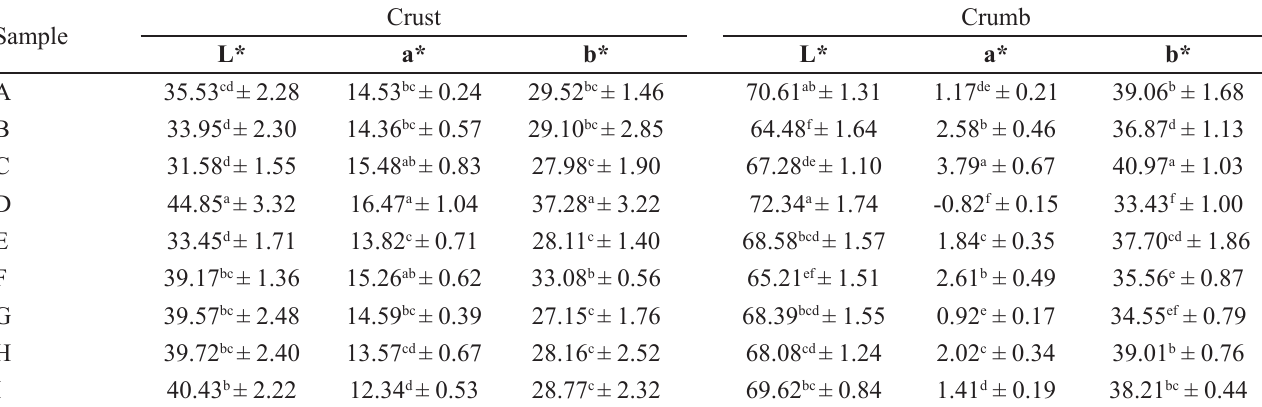
TABLE III - Crumb and crust color of panettone samples Sample